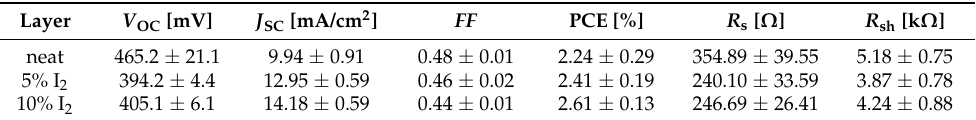
Table 2. Parameters of BHJ devices under illumination.